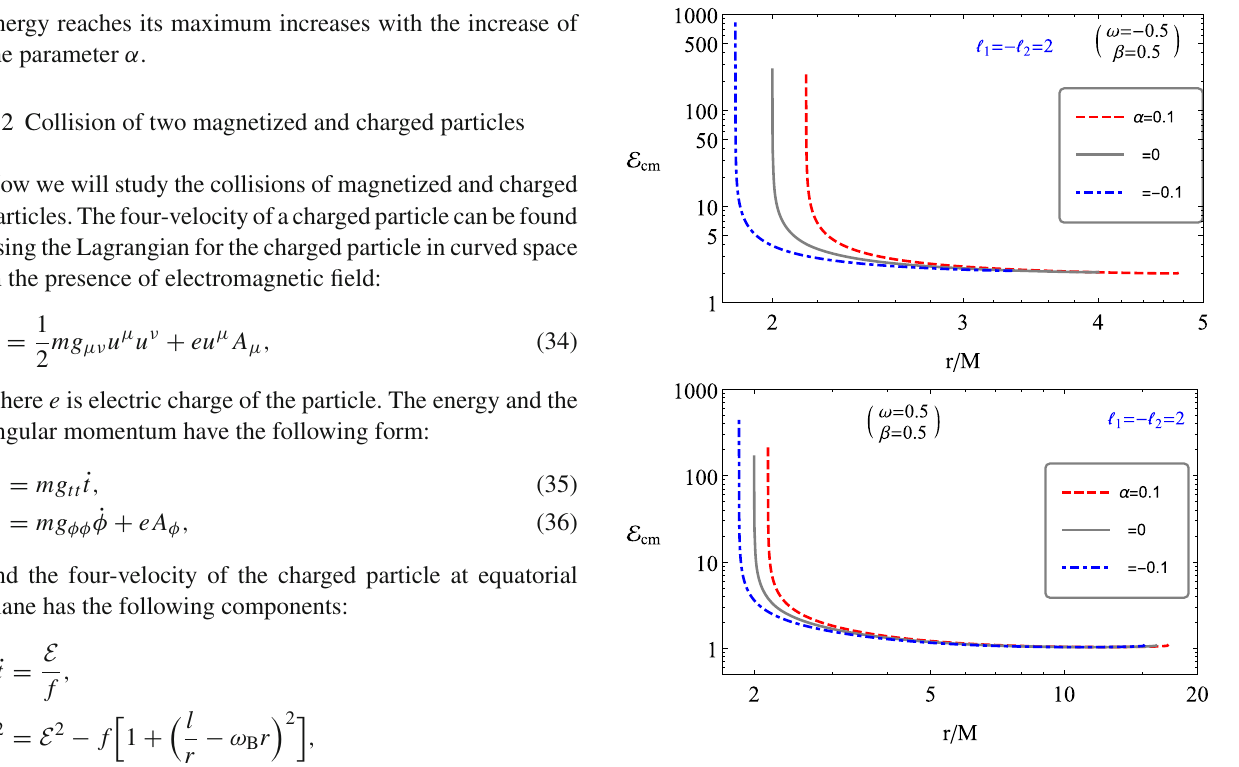
Fig. 7 The radial dependence of the center-of-mass energy of colli- sion of charged and magnetized particles with the same initial energy = E = 1, around Schwarzschild-MOG black hole for the different E 1 2 values of α parameter. Top and bottom panels correspond to the cases